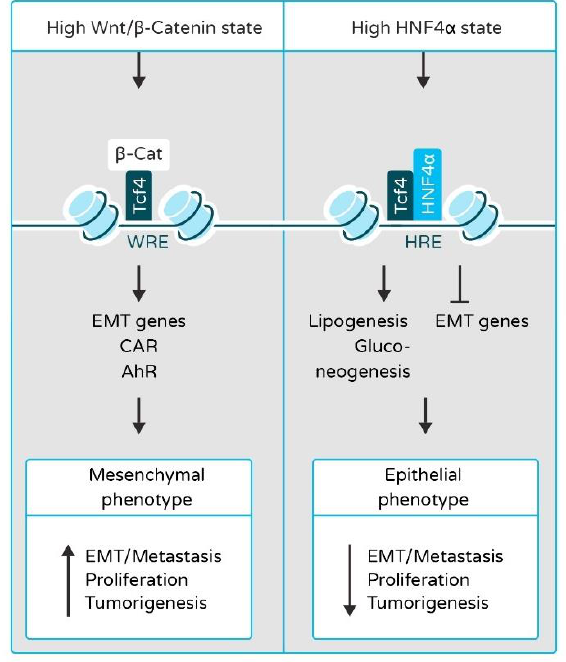
Figure 2. Interactions among β -catenin, HNF4 α , and T-cell factor 4 (Tcf4) in hepatocytes determines the progression of hepatocarcinogenesis. In high β -catenin state, β -catenin binds to Tcf4 and this complex binds to Wnt response elements (WREs) in promoters of target genes in hepatocytes (like constitutive androstane receptor, CAR, and aryl hydrocarbon receptor, AhR) and competitively inhibits the expression of HNF4 α and HNF4 α responsive genes, thus promoting EMT and tumorigenesis (Left panel). In high HNF4 α state, HNF4 α binds to HNF4 α response elements (HREs) in promoters of target genes to induce their expression and inhibits epithelial–mesenchymal transition (EMT) and tumorigenesis. Furthermore, HNF4 α inhibits β -catenin transcription and prevents β -catenin/TCF complex binding to target gene promoters (Right panel).